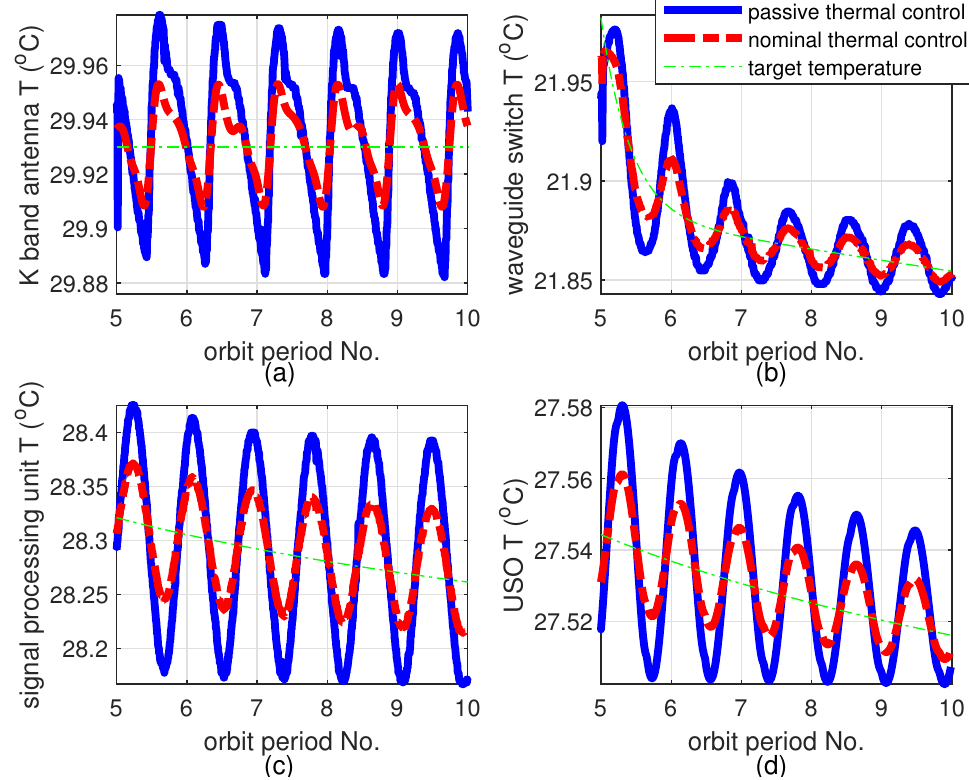
Figure 5. The thermal states of K-band MWR payloads during test. ( a ) K-band antenna; ( b ) waveguide switch network; ( c ) signal process unit; ( d )